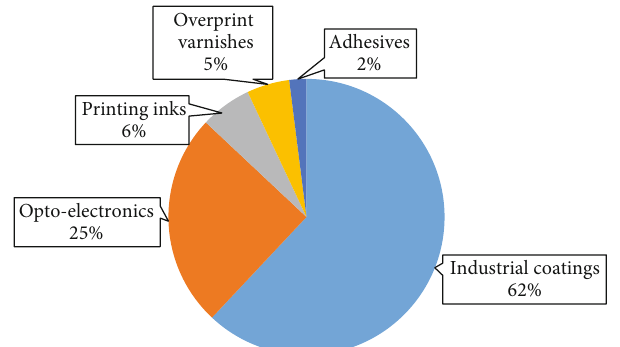
Figure 5: Market of acrylated epoxidized palm oil in Malaysia